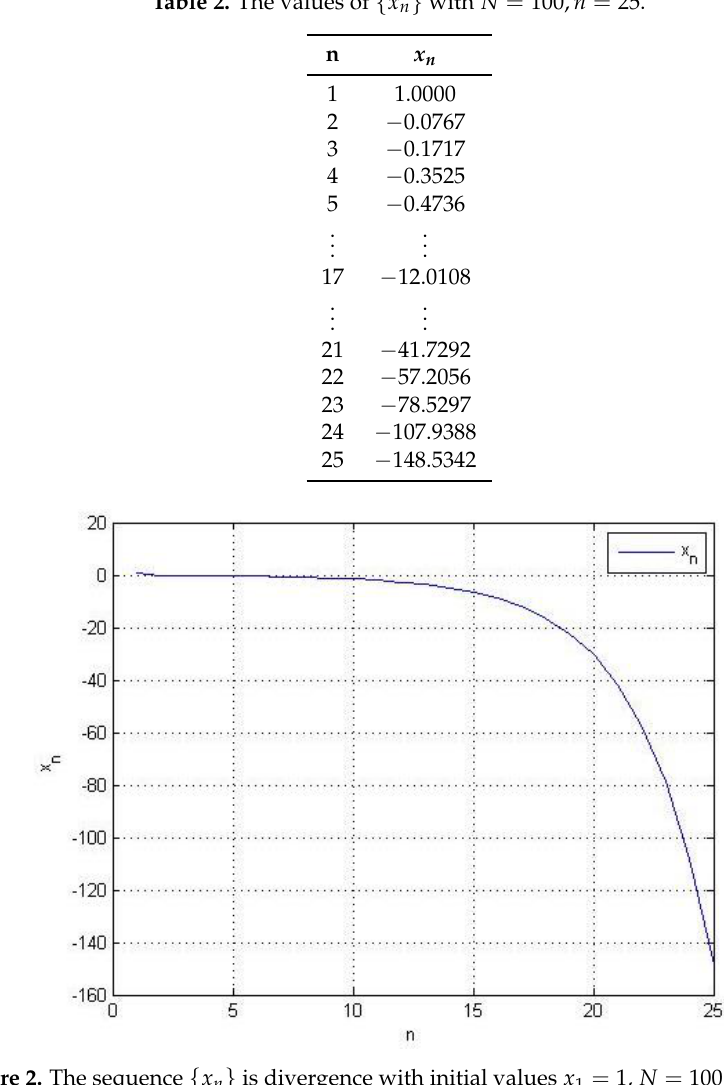
Table 2. The values of { x n } with N = 100, n = 25.